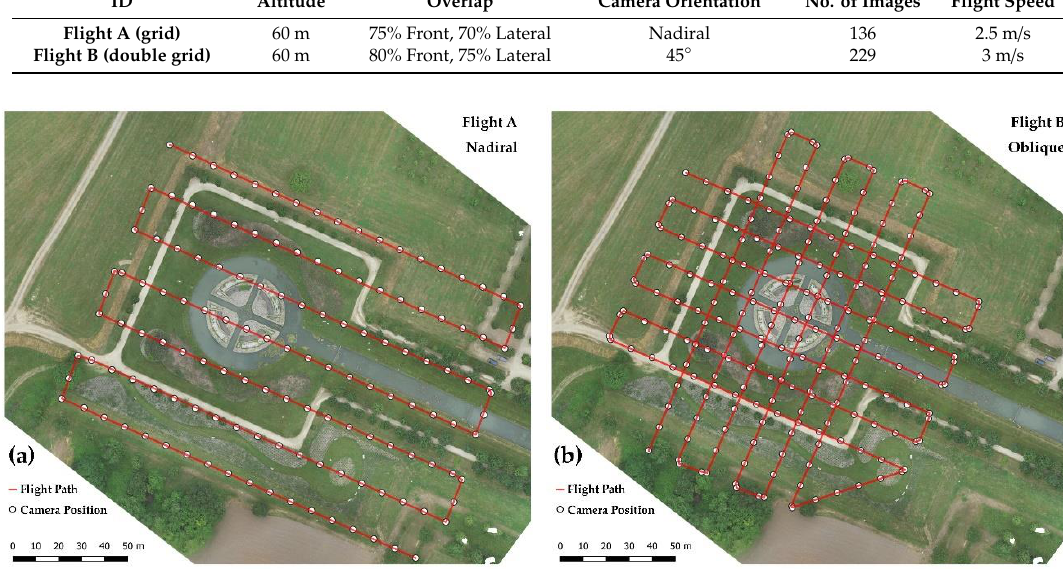
Figure 3. Flight plans of the flights performed at the Tempio di Diana. Flight A with a nadiral camera configuration ( a ) and Flight B with an oblique camera configuration ( b ).